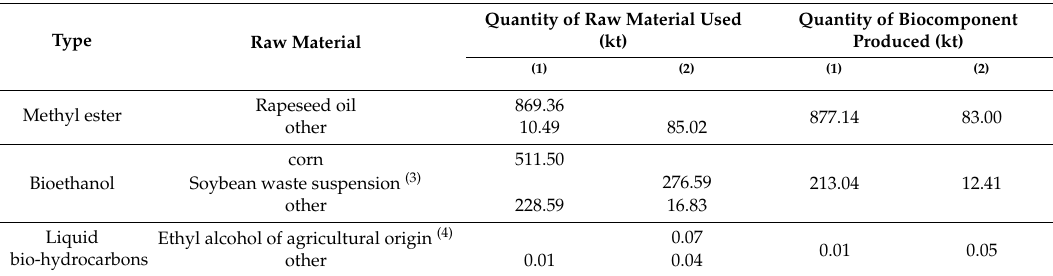
Table 2. Quantity of raw materials used and biocomponents produced using them in Poland in 2019